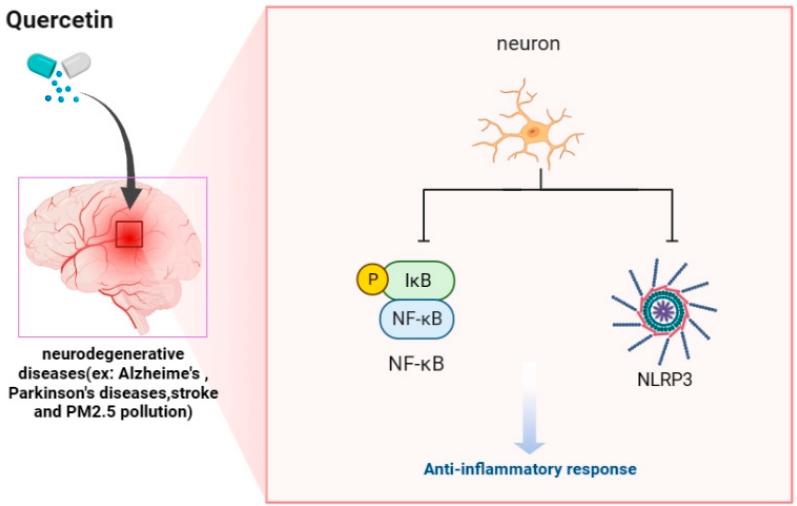
Figure 2. Quercetin is an anti-inflammatory agent for NF-kB and NLRP3 inflammasome in the brain of AD, PD, stroke, and PM 2.5 pollution.